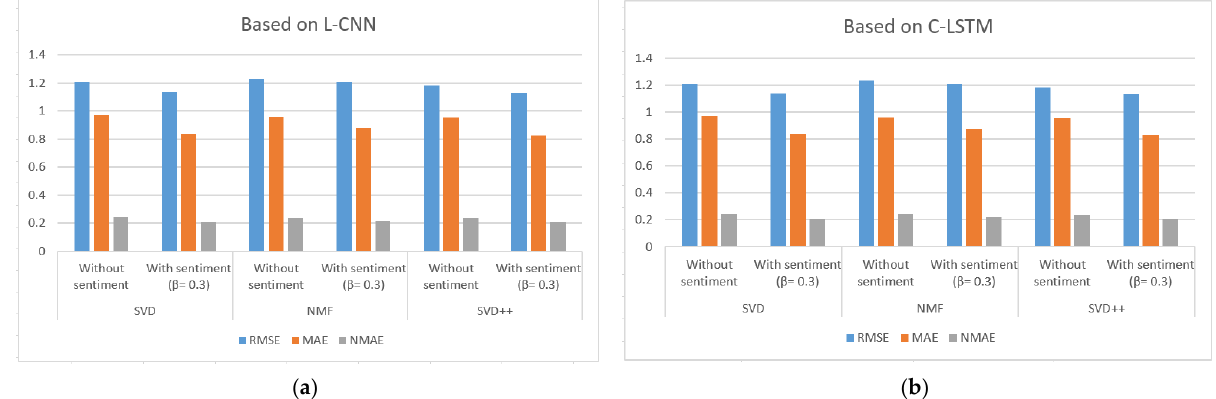
Figure 9. Comparison of the sentiment-based methods with the L-CNN model ( a ) and the C-LSTM ( b ) and β = 0.3 against non-sentiment-based methods on Amazon Fine Foods Reviews.